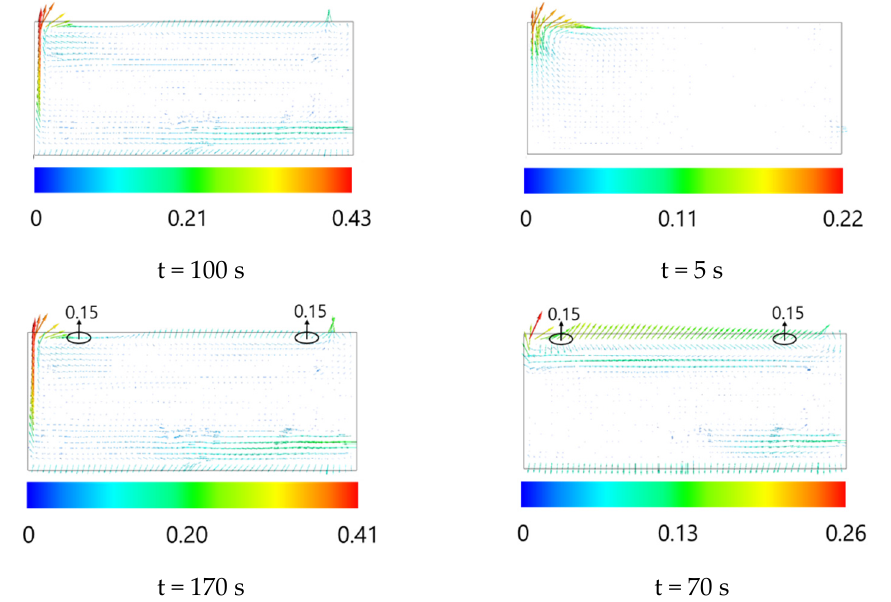
Figure 7. Velocity vectors for Model 4 (left) and Model 5 (right) whilst the envelope of 4% mole fraction of hydrogen was rising to the ceiling (up) and filling the whole ceiling (down) (m/s).